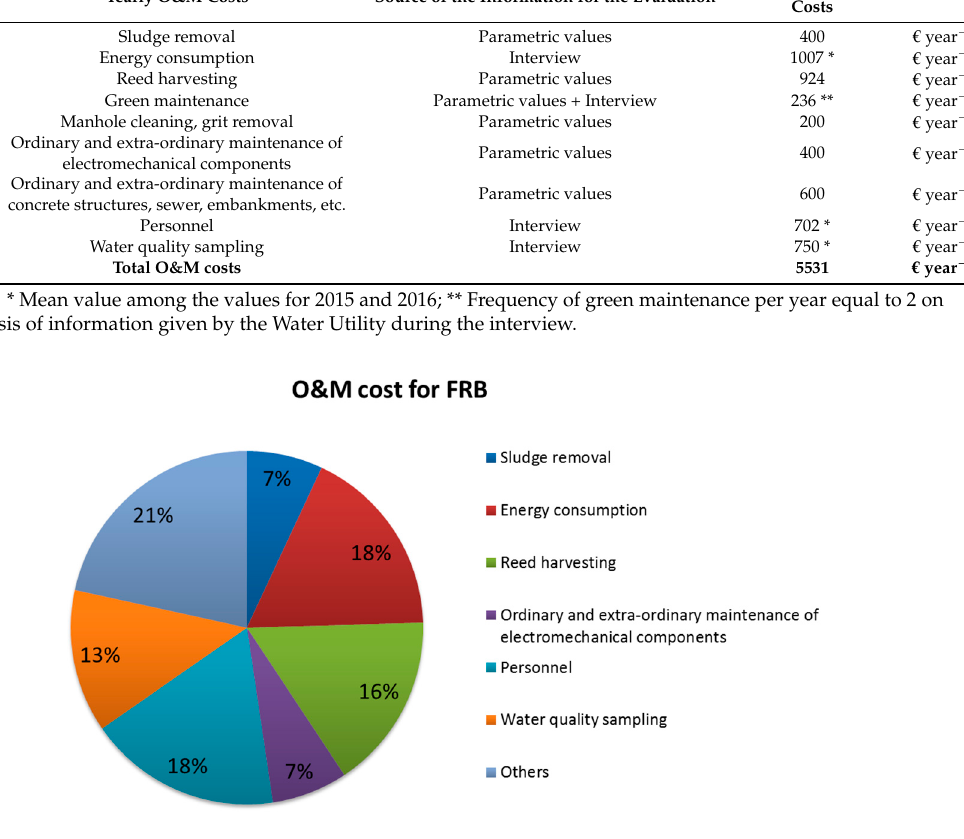
Table 6. Comparison of average removal efficiencies of the FRB WWTP of Castelluccio di Norcia with the data from the ample French dataset analyses.